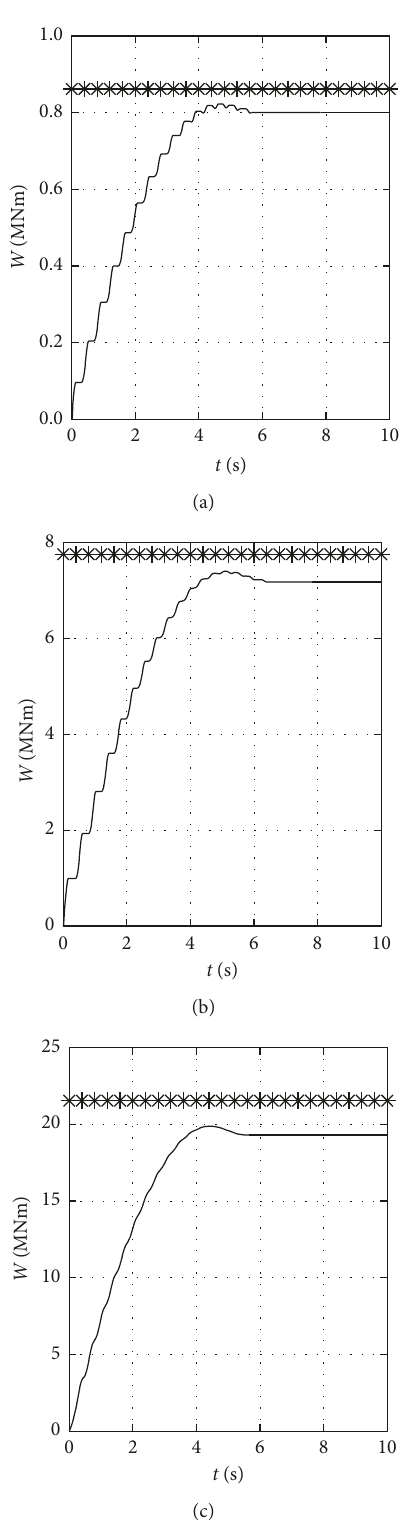
Figure 21: Energy absorbed by the optimum device ( ) and the total impact energy ( ) during impact corresponding to the impact scenarios (a) IS 31 , (b) IS 32 , and (c) IS 33